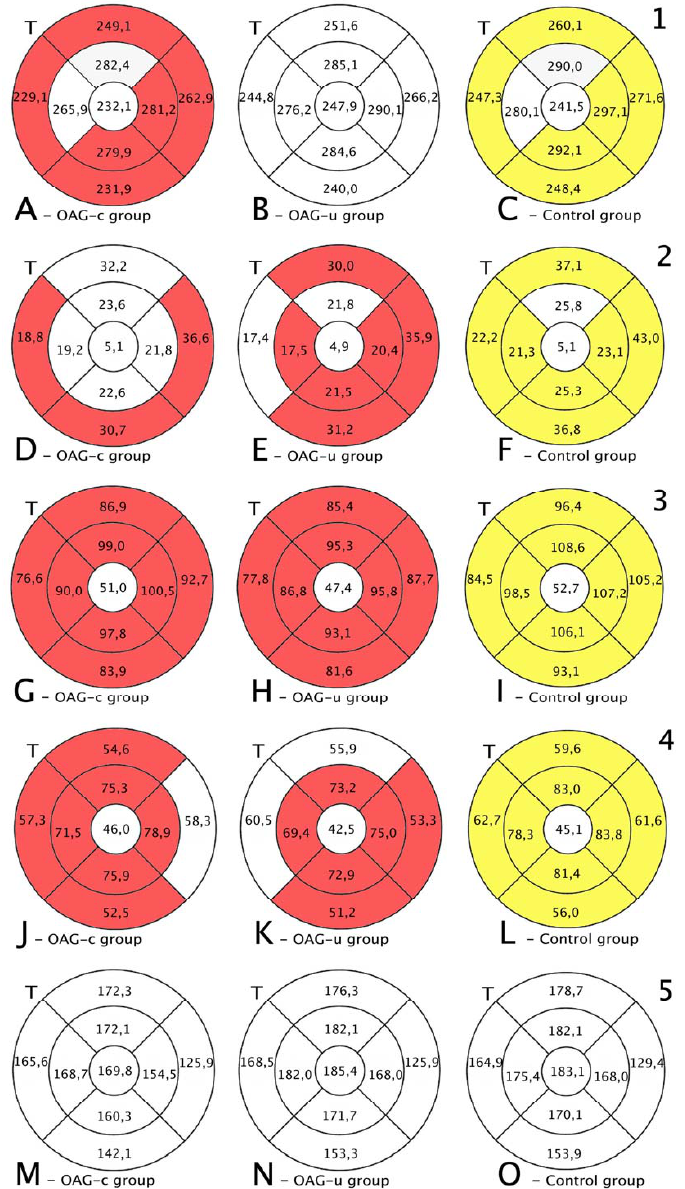
Figure 7. Comparison of posterior segment OCT results in ETDRS–9 subsegments and retinal lay- ers before the cataract surgery between control and OAG c or OAG u groups. ( A – C ) total macular thickness, ( D – F ) RNFL thickness, ( G – I ) GCL++ thickness, ( J – L ) GCL+ thickness, ( M – O ) choroid thickness. Temporal side (T) is shown on the left. Mean layer thickness is shown in ETDRS–9 subseg- ments. Colours mark statistically significant differences: yellow—statistically significantly higher mean thickness, red—statistically significantly lower mean thickness, white—statistically significant difference not